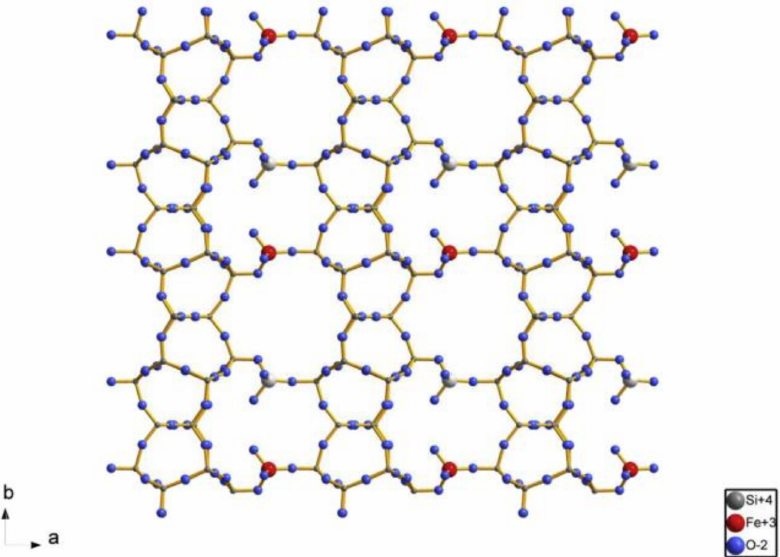
Figure 15. Projection along [001] of the framework of Fe-IEZ-CDO showing schematically the metal centers at every linker site. Reprinted with permission from ref. [66]. Copyright 2016,